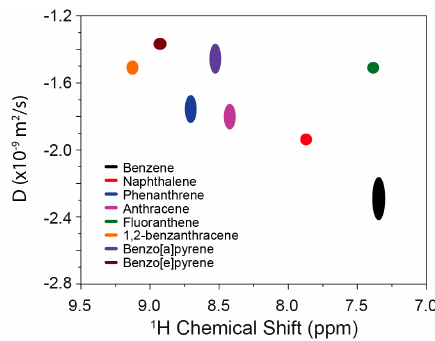
Figure 6. Diffusion-ordered NMR spectroscopy (DOSY) plot for different polycyclic aromatic hydrocarbons in CDCl 3 .